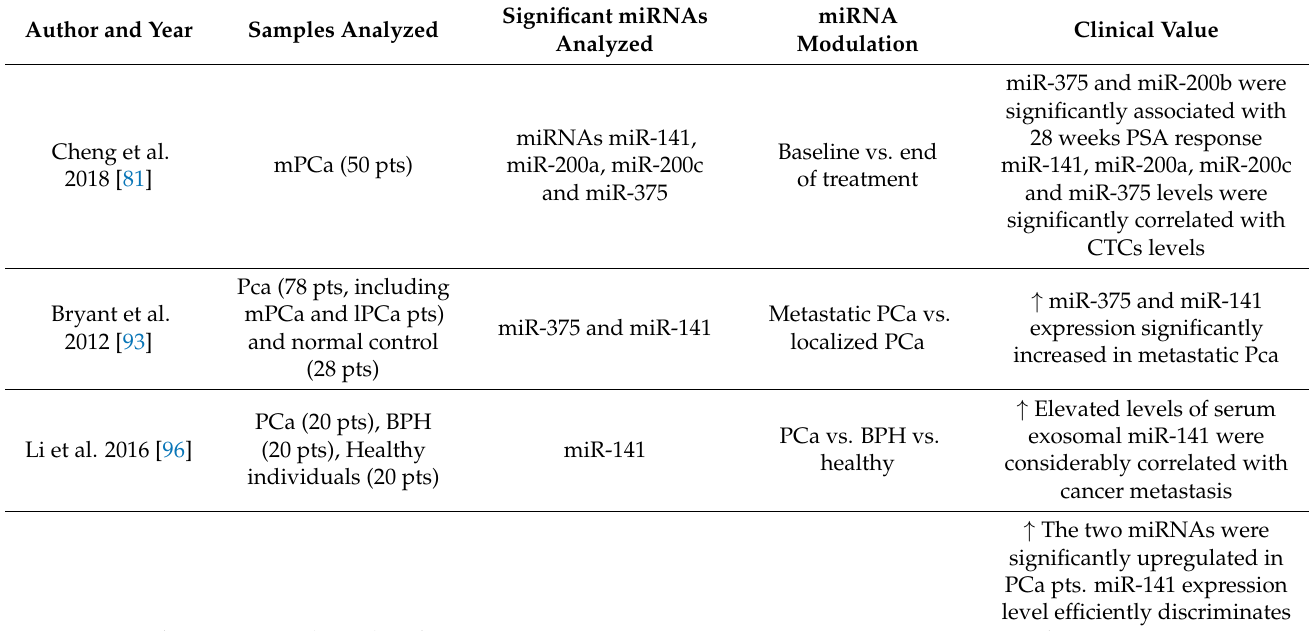
Table 1. Summary of some of the main studies investigating the role of miRNAs in PCa carcinogenesis and their relationship with the clinical course of the disease as well as their potential role as